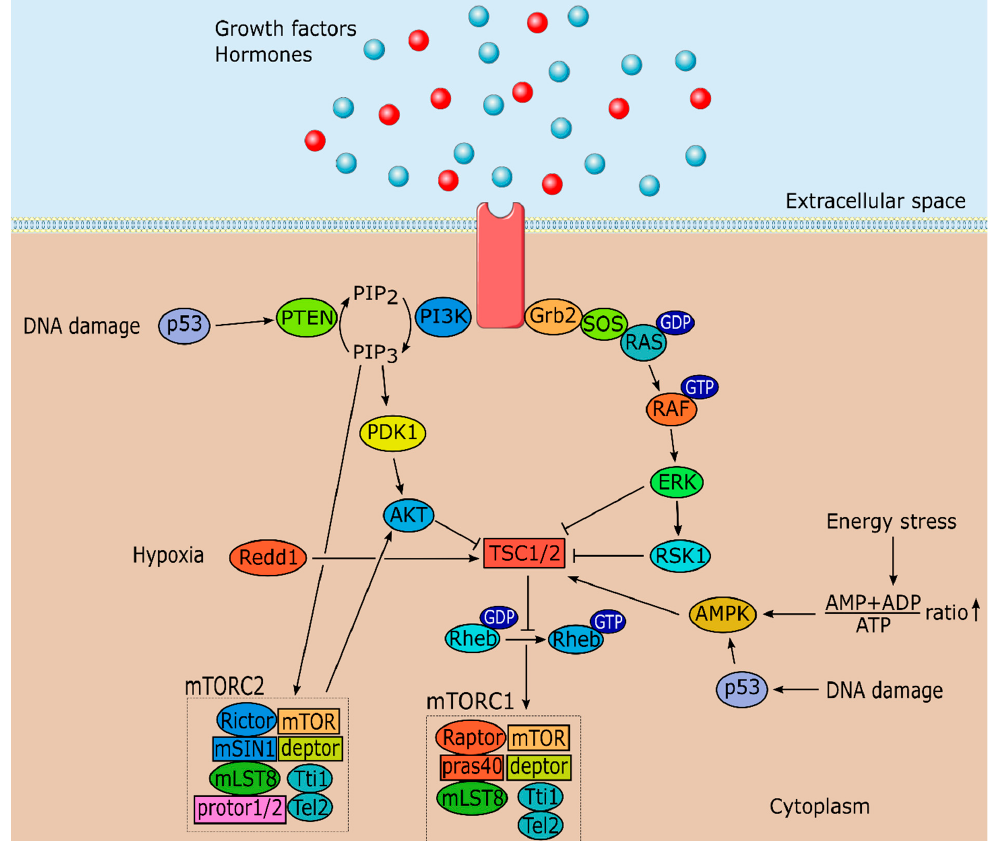
Figure 1. Schematic illustration of rapamycin (mTOR) signaling pathway. mTOR forms two functional complexes, mTORC1 and mTORC2 which are involved in different physiological processes. mTORC1 is regulated by growth factors/hormones, DNA damage, energy status and oxygen levels. mTORC2 is also regulated by growth factors and is involved in AKT phosphorylation. Abbreviations: AKT: protein kinase B; AMPK: AMP-activated protein kinase; deptor: DEP (Dishevelled, Egl-10 and Pleckstrin) domain-containing mTOR-interacting protein; ERK: Extracellular signal regulated kinase; Grb2: Growth factor receptor bound protein 2; mLST8: Mammalian lethal with sec-13 protein